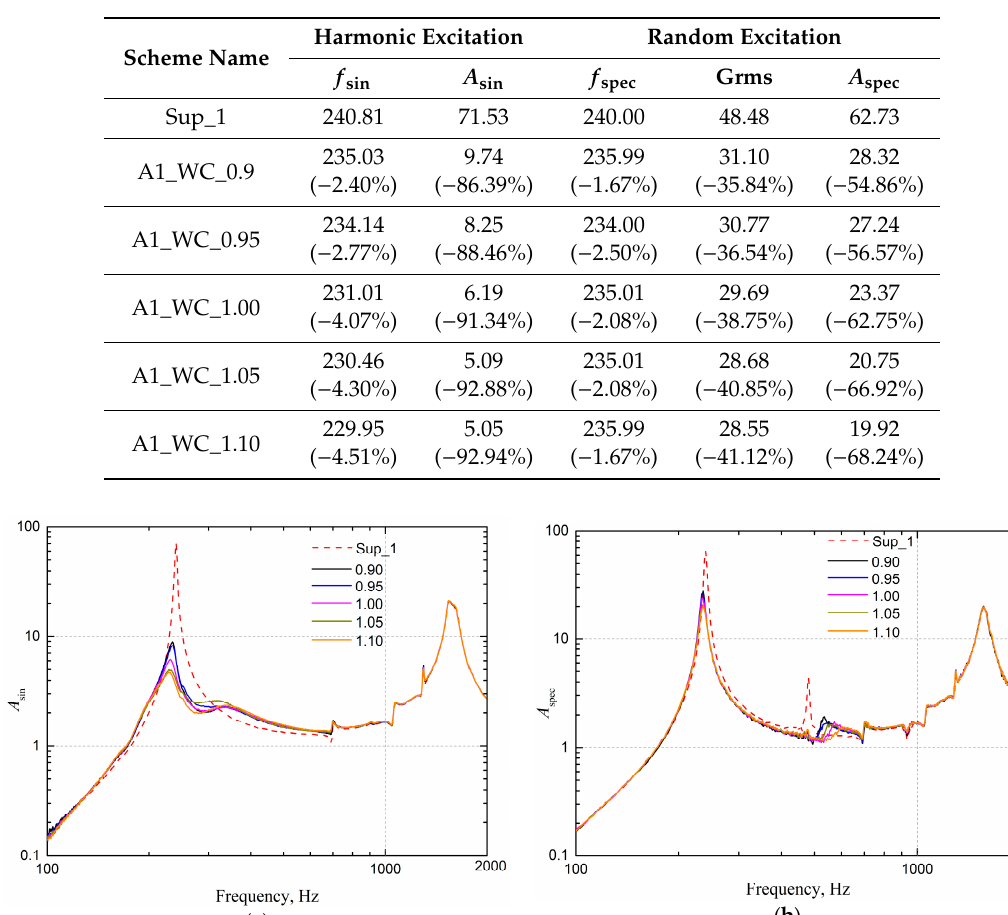
Table 11. E ff ect of tungsten carbide powder filling coe ffi cient. Table 11. Effect of tungsten carbide powder filling coefficient.